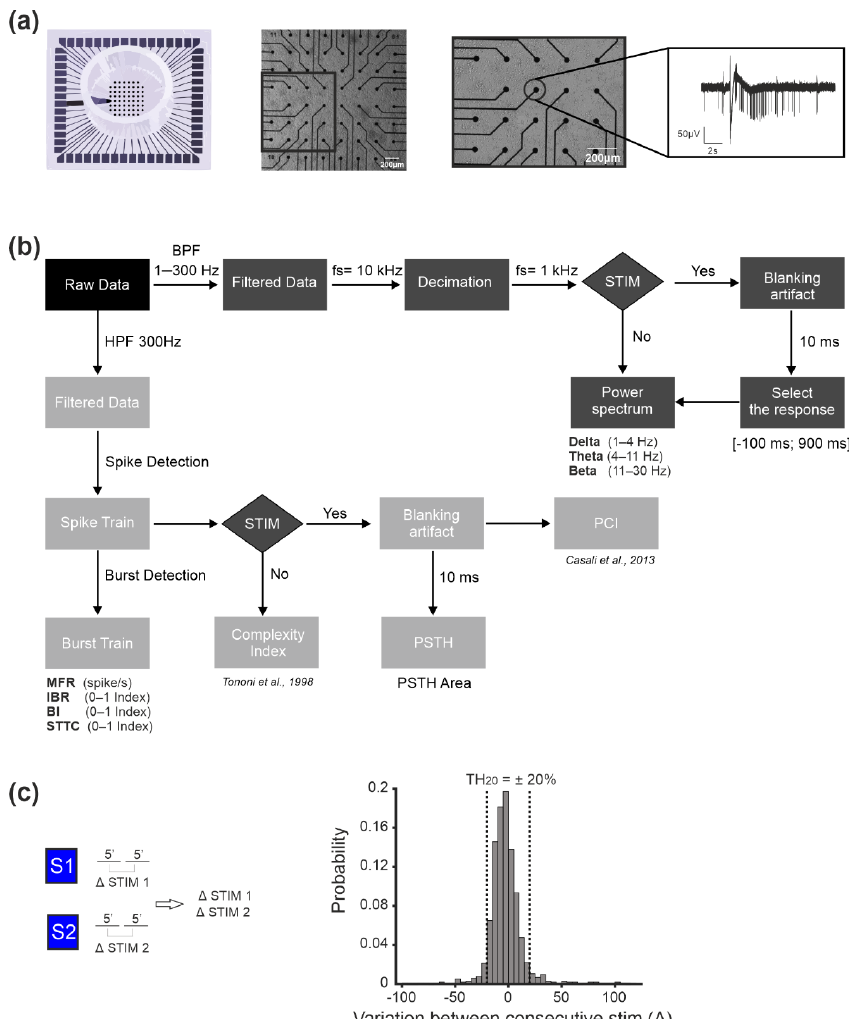
Figure 1. Methods of our experiments. ( a ) From left to right: cartoon of a 60–channel micro-electrode array (MEA) by MCS with a standard electrode layout (8 × 8); optical micrograph of a MEA plated with cortical cultures (scale bar 200 µ m); zoom of the squared area highlighted in the previous picture (scale bar 200 µ m); a typical raw trace recorded from a representative micro-electrode of the MEA. ( b ) Scheme of the data analysis workflow. Data were acquired by means of the MC_Rack software (MCS). We then processed it by following two approaches: (i) by band pass filtering in the frequency band 1 – 300 Hz, we obtained filtered data which was then decimated at 1 kHz, i.e., the local field potentials (LFPs); (ii) by high pass filtering (>300 Hz) we obtained filtered data which were processed by means of a spike detection algorithm, to obtain the multi-unit activity (MUA). The MUA was further analyzed to detect firing and bursting parameters and to compute the correlation index, in the form of the spike time tiling coefficient (STTC). For both (i) and (ii), we analyzed the spontaneous as well as the evoked activity (see Methods for details on the analysis). ( c ) Selection of the PSTH threshold during the stability phases (see Methods). On the left, the variation in the PSTH area in the basal condition is computed by considering the responses to stimulation in the first and in the second five-minute time frames. The variation in the percentage of the PSTH area for all the channels in all the experiments was then plotted as a histogram (rigth panel) which served to define the ‘natural’ fluctuation range of the considered parameter. The threshold was then defined as the mean ± 1SD of the PSTH area variation of the obtained histogram, which resulted I being equal to ± 20%. We then named that threshold TH 20